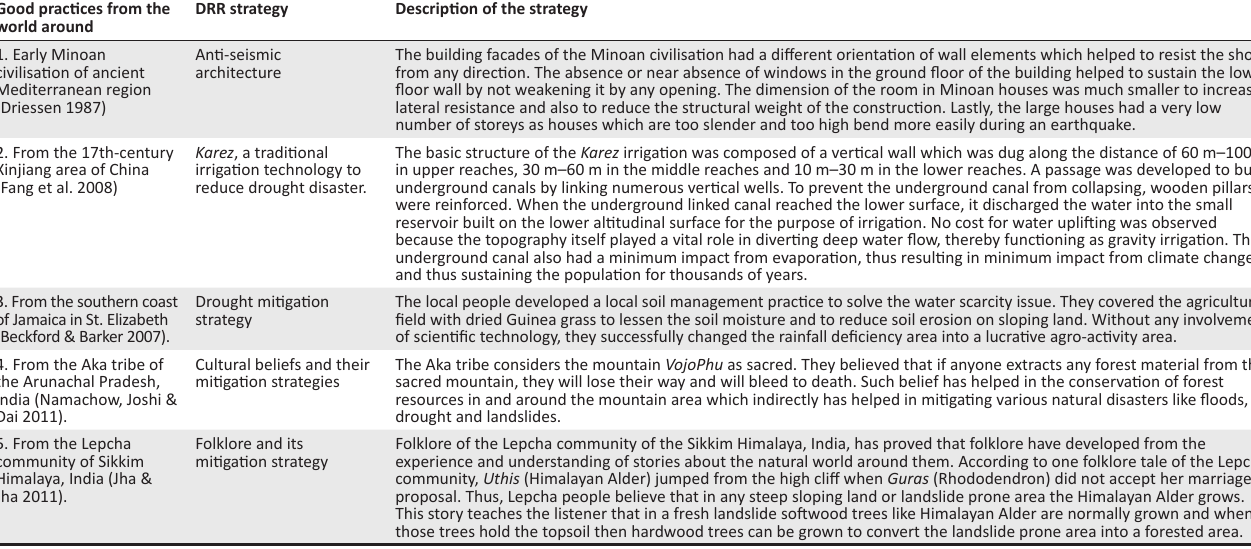
TABLE 1: Traditional knowledge in disaster risk reduction: Good practices from the world